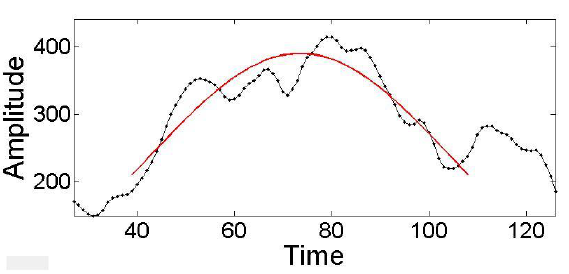
Fig. 3. Fit of a parabola to a candidate pupil dilation